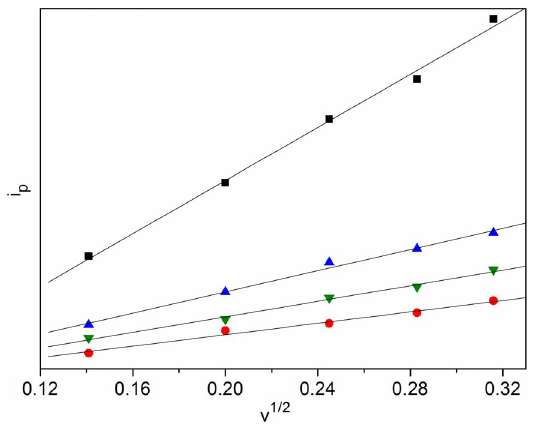
Figure 3. Cyclic voltammograms of Eu(III) measured in BmimBr with different scan rates.